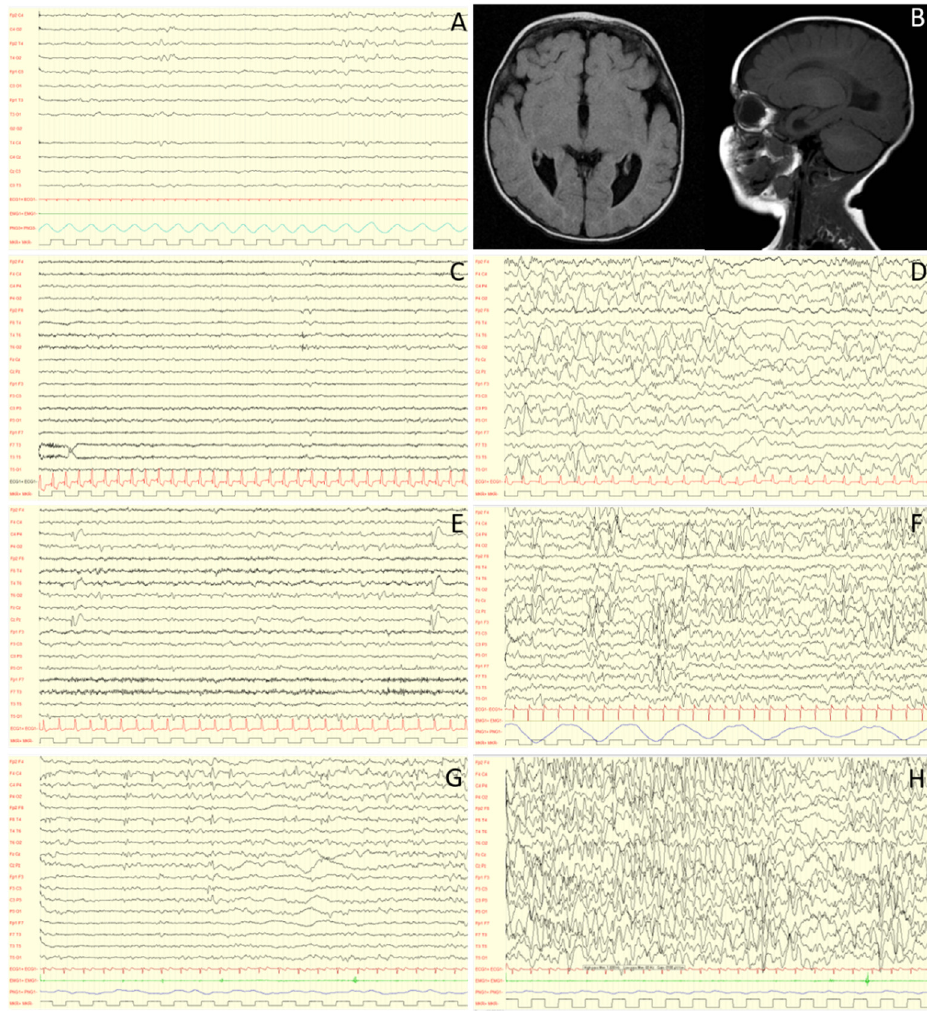
Figure 2. EEG evolution at 0 ( A ), 3 ( C , D ), 5 ( E , F ) and 9 ( G , H ) years old, and RM features ( B ) of a MWS individual. Caption: At birth, electroencephalographic activity is essentially normal ( A ). With time, a worsening is observed, with an increase in paroxysmal abnormalities in wakefulness ( C , E , G ), dramatically activated during sleep ( D , F , H ). MRI images performed at 4 months show complete agenesis of the corpus callosum ( B ). Interestingly, abnormalities in sleep can sometimes appear asynchronous although bilateral: this is probably related to this type of malformation. Note: low frequency filter: 1.6 Hz; high frequency filter: 60 Hz; paper speed: 20mm/sec; sensitivity: 150 microV/cm ( A , C , D , E , F